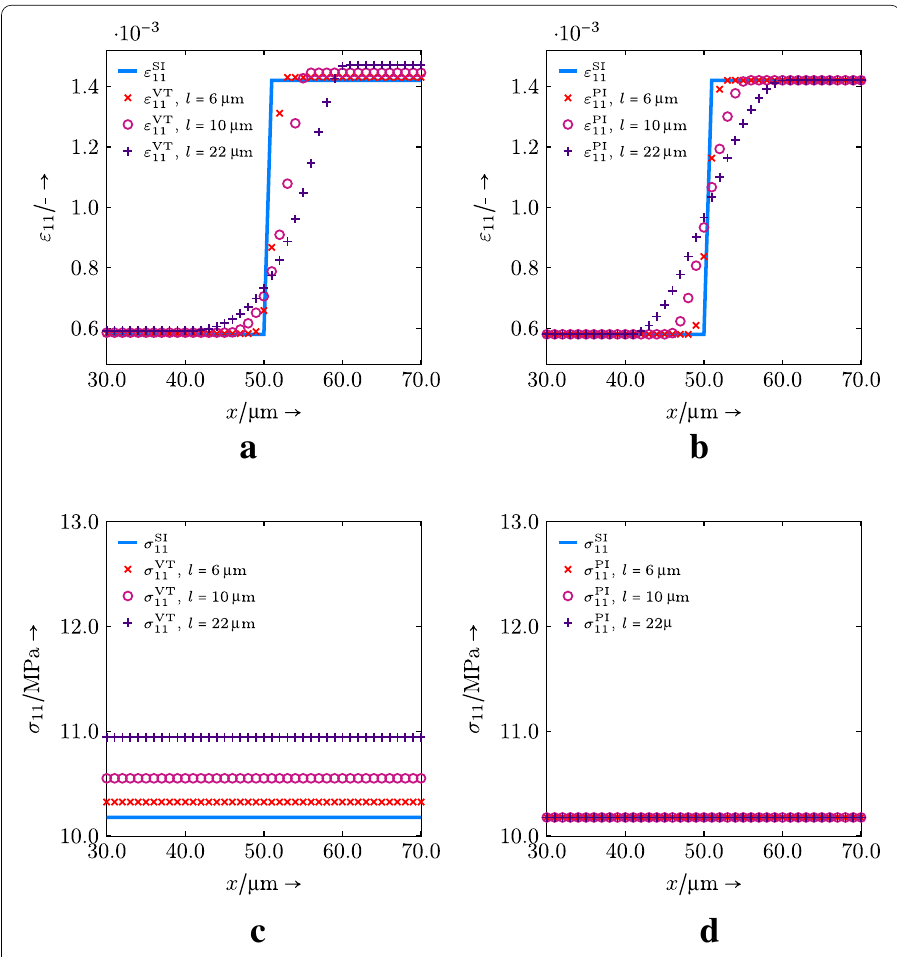
Fig. 8 Influence of different interfaces widths: Results for ε 11 and σ 11 compared to a sharp-interface solution at t = 20s. The results of the VT approach are depicted in a and c , while the PI approach is shown in b and d . Three interface width of l = { 6 , 12 , 22 } µ m are plotted along x with y = 49 . 5 µ